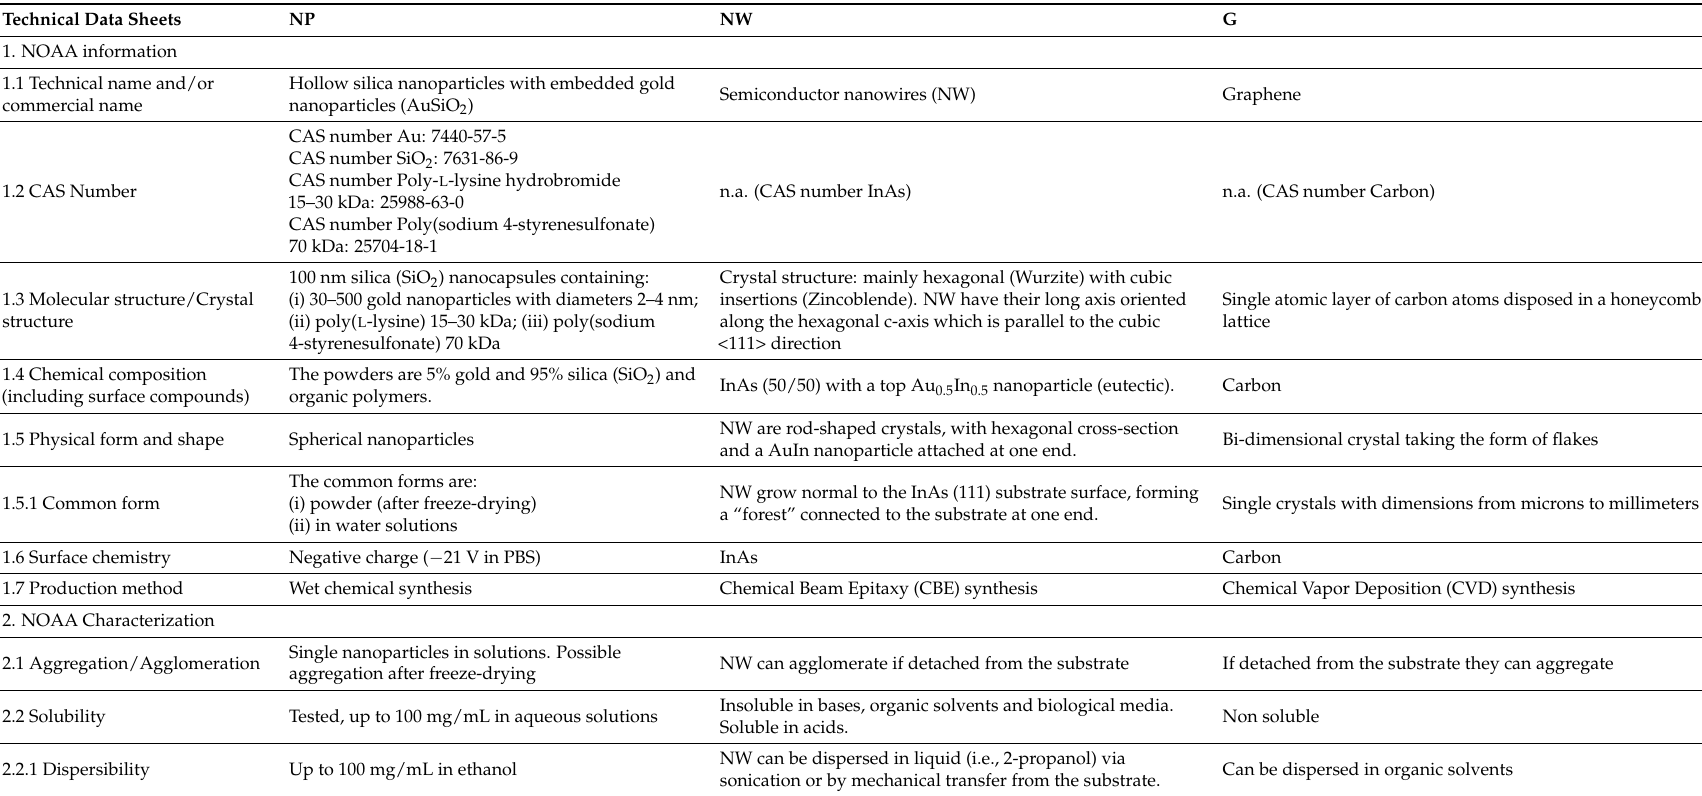
Table A1. Technical Data Sheets of Three Nanomaterials: Nanoparticles (NP), Nanowires (NW), and Graphene (G). n.a.: not